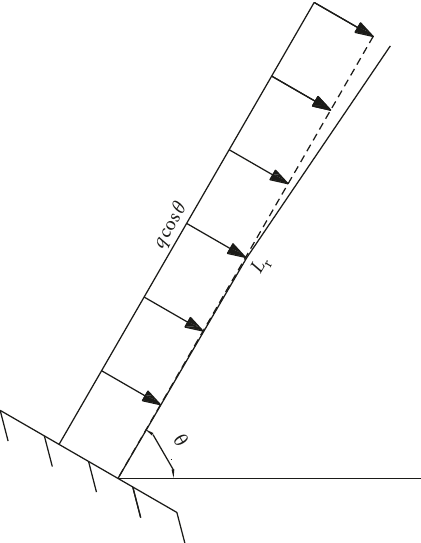
Figure 3: Mechanical model for roof breakage with the cantilever